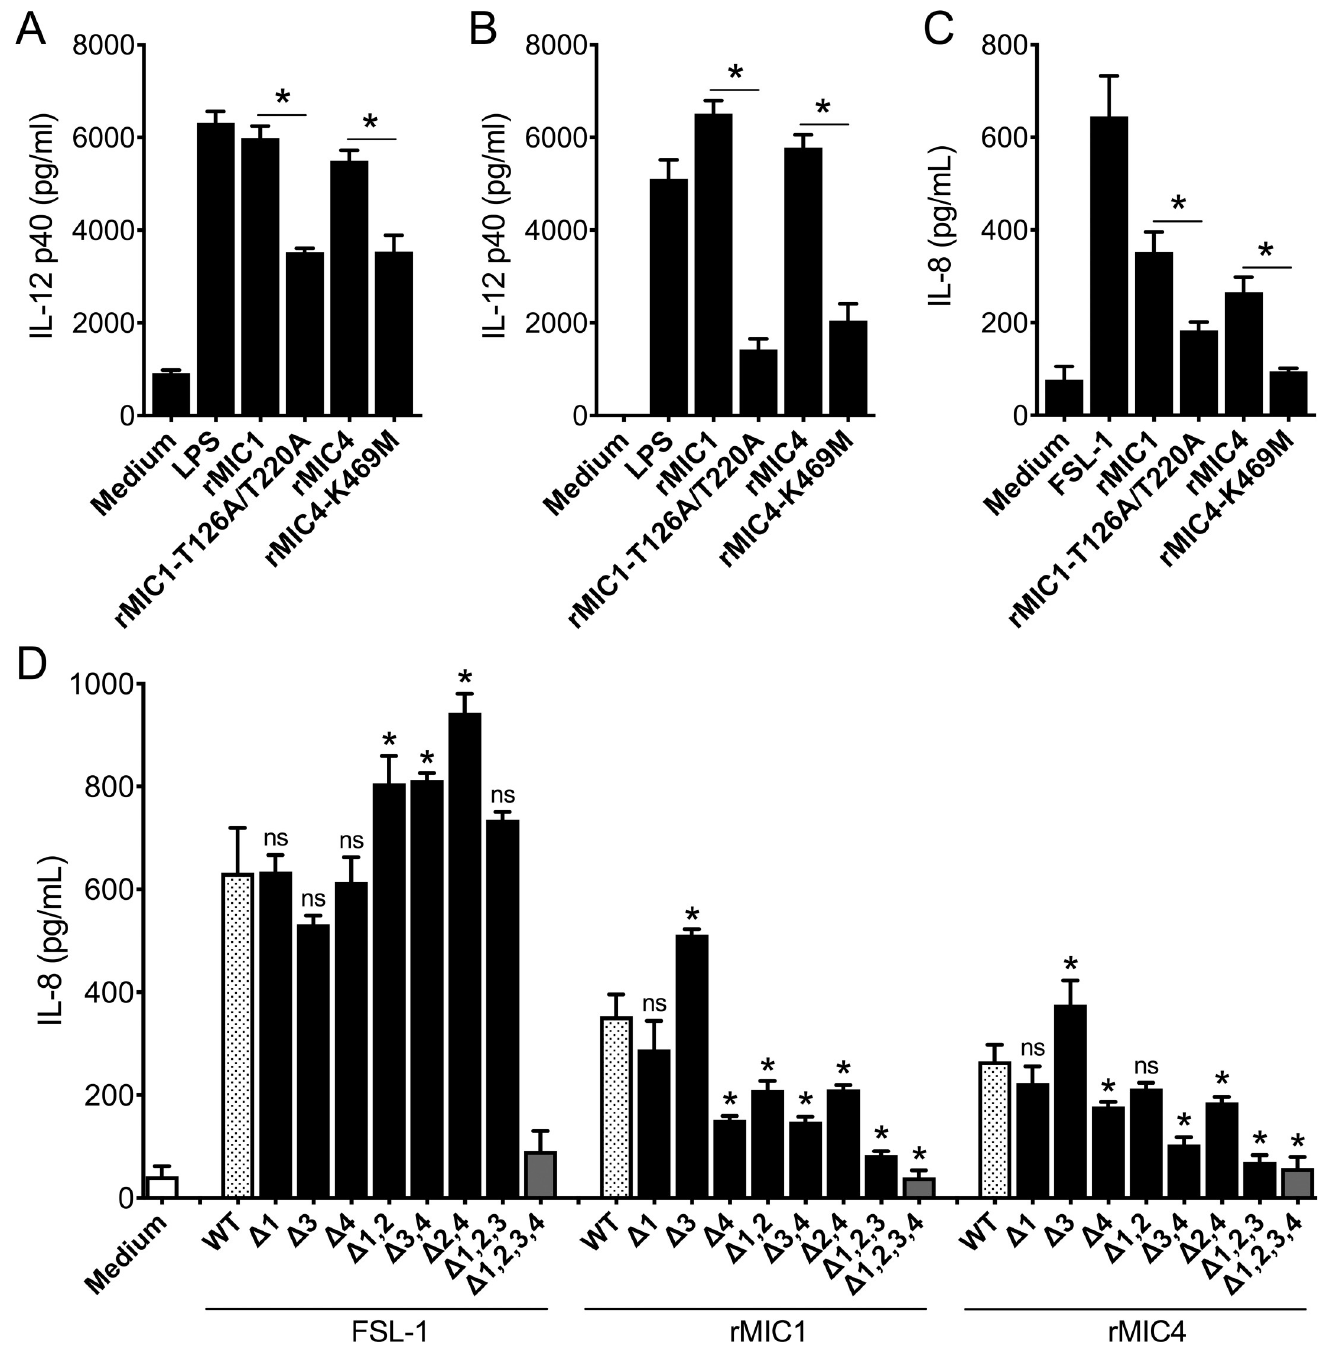
Fig 4. The cellular activation induced by rMICs via TLRs depends on carbohydrate recognition. (A) Bone marrow-derived macrophages and (B) bone marrow- derived dendritic cells from C57BL/6 mice and (C) transfected HEK293T cells expressing fully glycosylated TLR2 were stimulated with rMIC1 (WT) and rMIC4 (WT) or with their mutated forms, rMIC1-T126A/T220A and rMIC4-K469M, 5 μ g/mL of each, for 48 h. LPS (100 ng/mL) and FSL-1 (100 ng/mL) were used as positive controls. IL-12p40 and IL-8 levels were measured by ELISA. (D) HEK293T cells expressing fully glycosylated TLR2 (with 4 N-glycans, WT) or glycosylation mutants of TLR2 ( Δ -1; Δ -4; Δ -1,2; Δ -3,4; Δ -2,4; Δ -1,2,3; Δ -1,2,3,4) were stimulated with rMIC1 or rMIC4. FSL-1 (100 ng/mL) was used as positive control. IL-8 levels were measured by ELISA. The statistical analysis compared fully glycosylated TLR2 (WT) and TLR2 mutants for the N-glycosylation sites for the same stimuli. For these assays, rMIC1, rMIC1-T126A/T220A, rMIC4 and rMIC4-K469M were passed through polymyxin B column, followed by incubation with polymyxin B sulphate salt media preparation that was added to the culture (see Material and Methods). Data are expressed as mean ± S.D. of triplicate wells and significance was calculated with ANOVA followed by Bonferroni’s multiple comparisons test. � p < 0.05. Data are representative of three independent experiments.